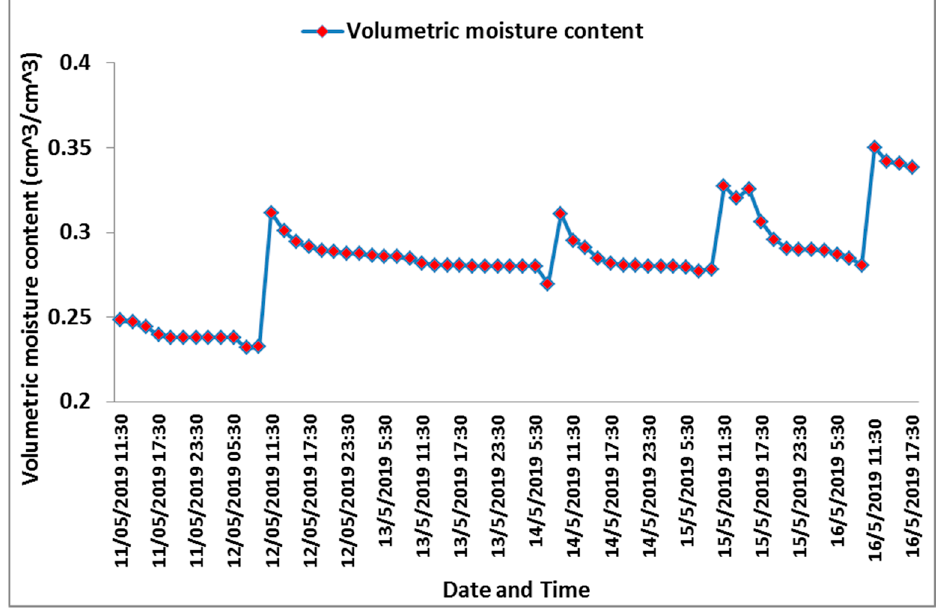
Figure 8. Volumetric moisture content ( Ɵ V ) recorded by the designed automated monitoring sys- tem.